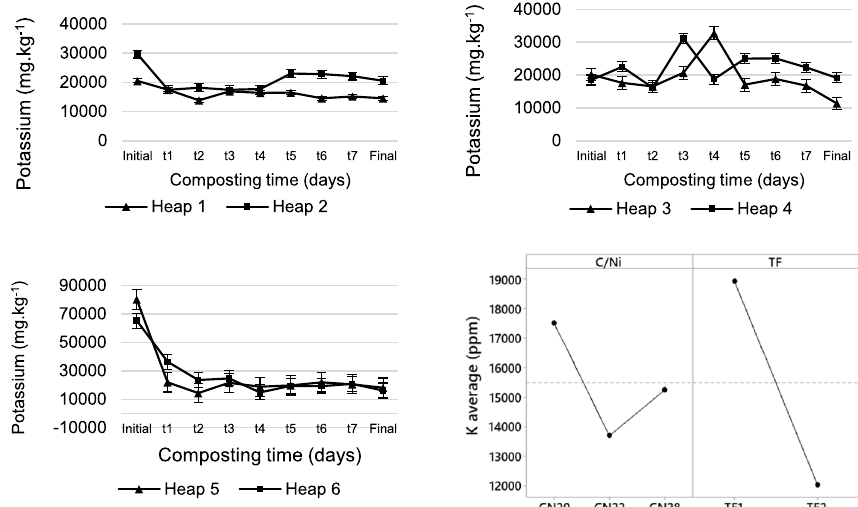
Fig. 2 Evolution of exchangeable potassium content during composting for the six heaps and factors’ effect diagram